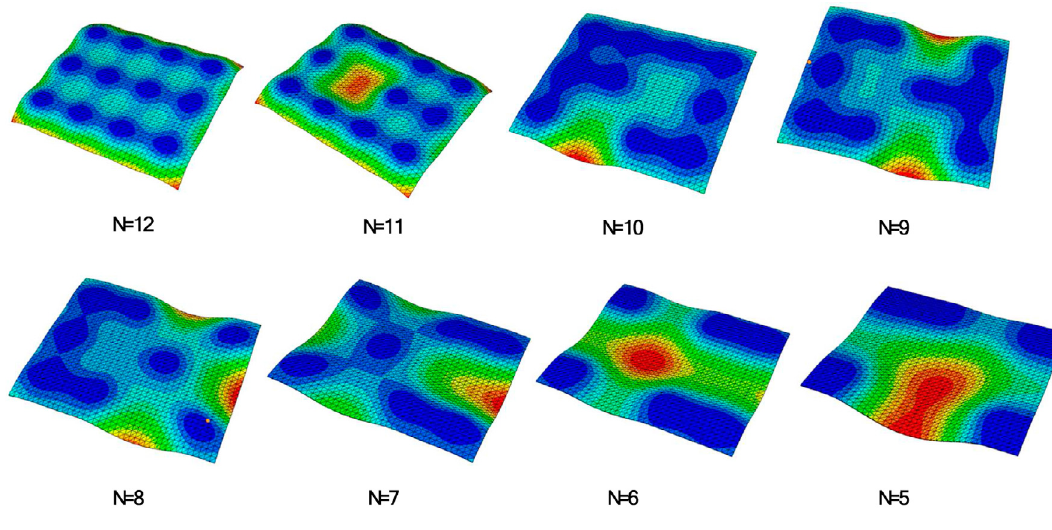
Figure 4. Result comparison in the software of ABAQUS.